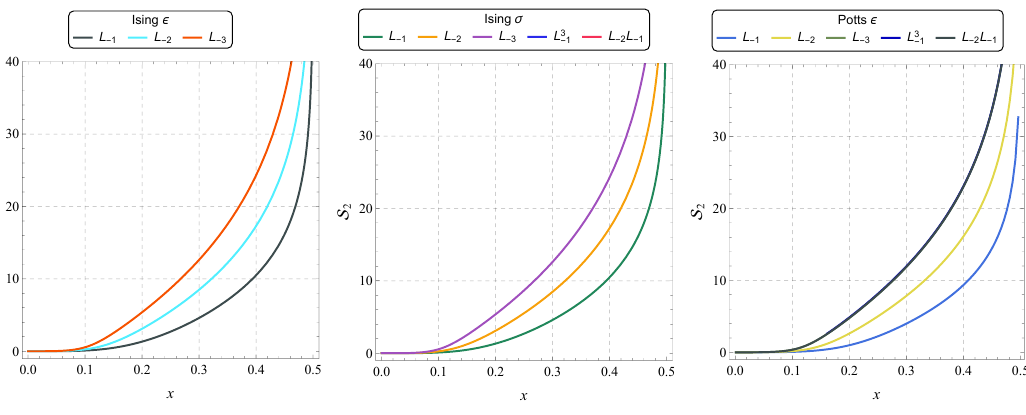
Figure 9 . The Sandwiched Rényi Divergence between the reduced groundstate and different de- scendants of | ε i and | σ i in the Ising model and | ε i in the Potts